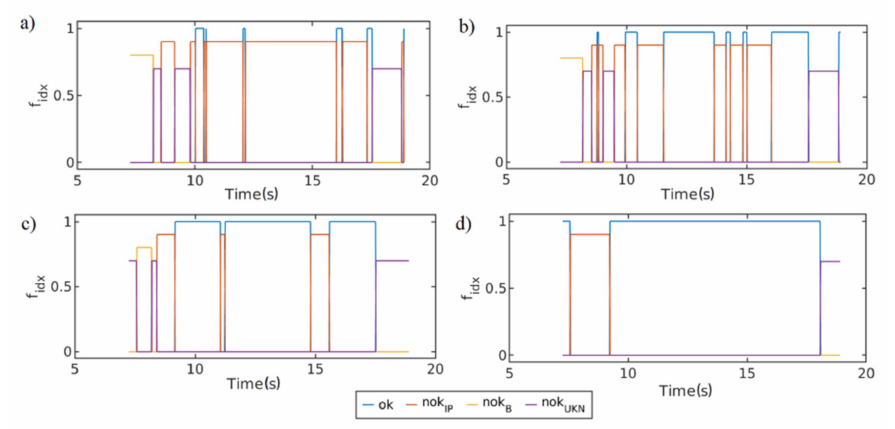
Figure 21. Comparison of detection results using cubic interpolation for sample S19 with different interpolation factors: ( a ) 2, ( b ) 24, ( c ) 48, and ( d ) 192.